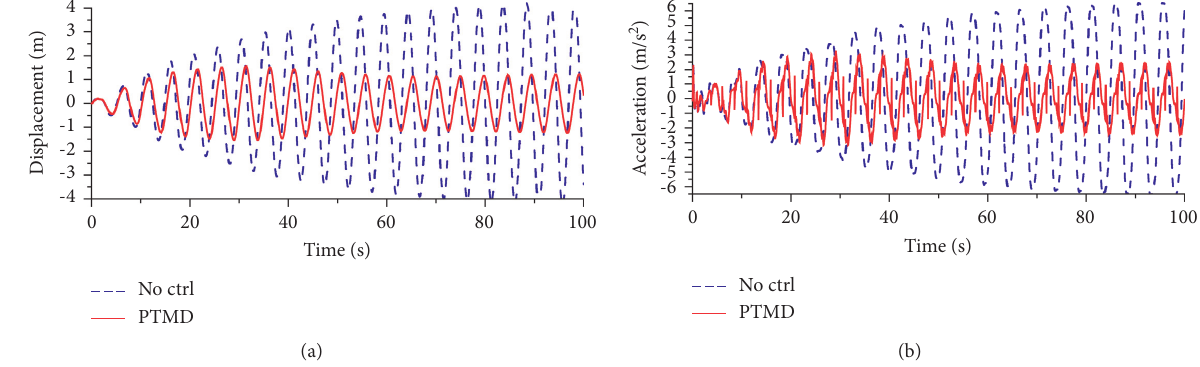
Figure 10: : Maximum response of the SCR under OC4: (a) displacement and (b) acceleration.